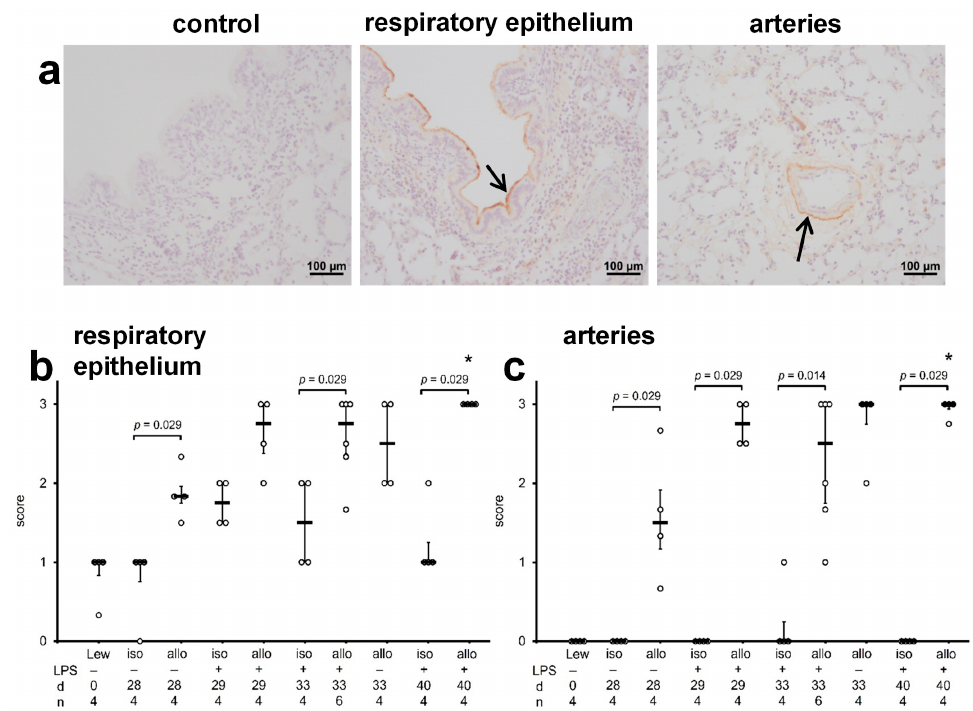
Figure 5. Deposition of C4d in lung tissue. C4d was detected by immunohistochemistry on paraffin sections of pulmonary isografts (iso) and allografts (allo). Grafts were investigated on postoperative day 28 (d 28) before intratracheal instillation of lipopolysaccharide (LPS) as well as on postoperative days 29 (d 29), 33 (d 33), and 40 (d 40), 1, 5, and 12 days after treatment with LPS, respectively. Immunopositive regions are stained in brown, and cell nuclei are lightly counterstained with hemalum. Examples of sections of d 40 allografts are depicted ( a ). In the section labeled control, the primary antibody was omitted ( a ). Further, examples showing C4d deposits on the respiratory epithelium (arrow) and on the arterial wall at the interface between media and intima (arrow) are depicted ( a ). The intensity of the C4d immunoreactivity on the respiratory epithelium and in the arterial wall was evaluated using a scoring system ranging from 0 for virtually no immunoreactivity to 3, the strongest immunoreactivity observed ( b , c ). Data are presented as individual data points, bar represents median, whiskers encompass the 25th to 75th percentile. Explorative data analysis was performed using Kruskal–Wallis test followed by Mann–Whitney U-test; * p ≤ 0.05, different from allo d